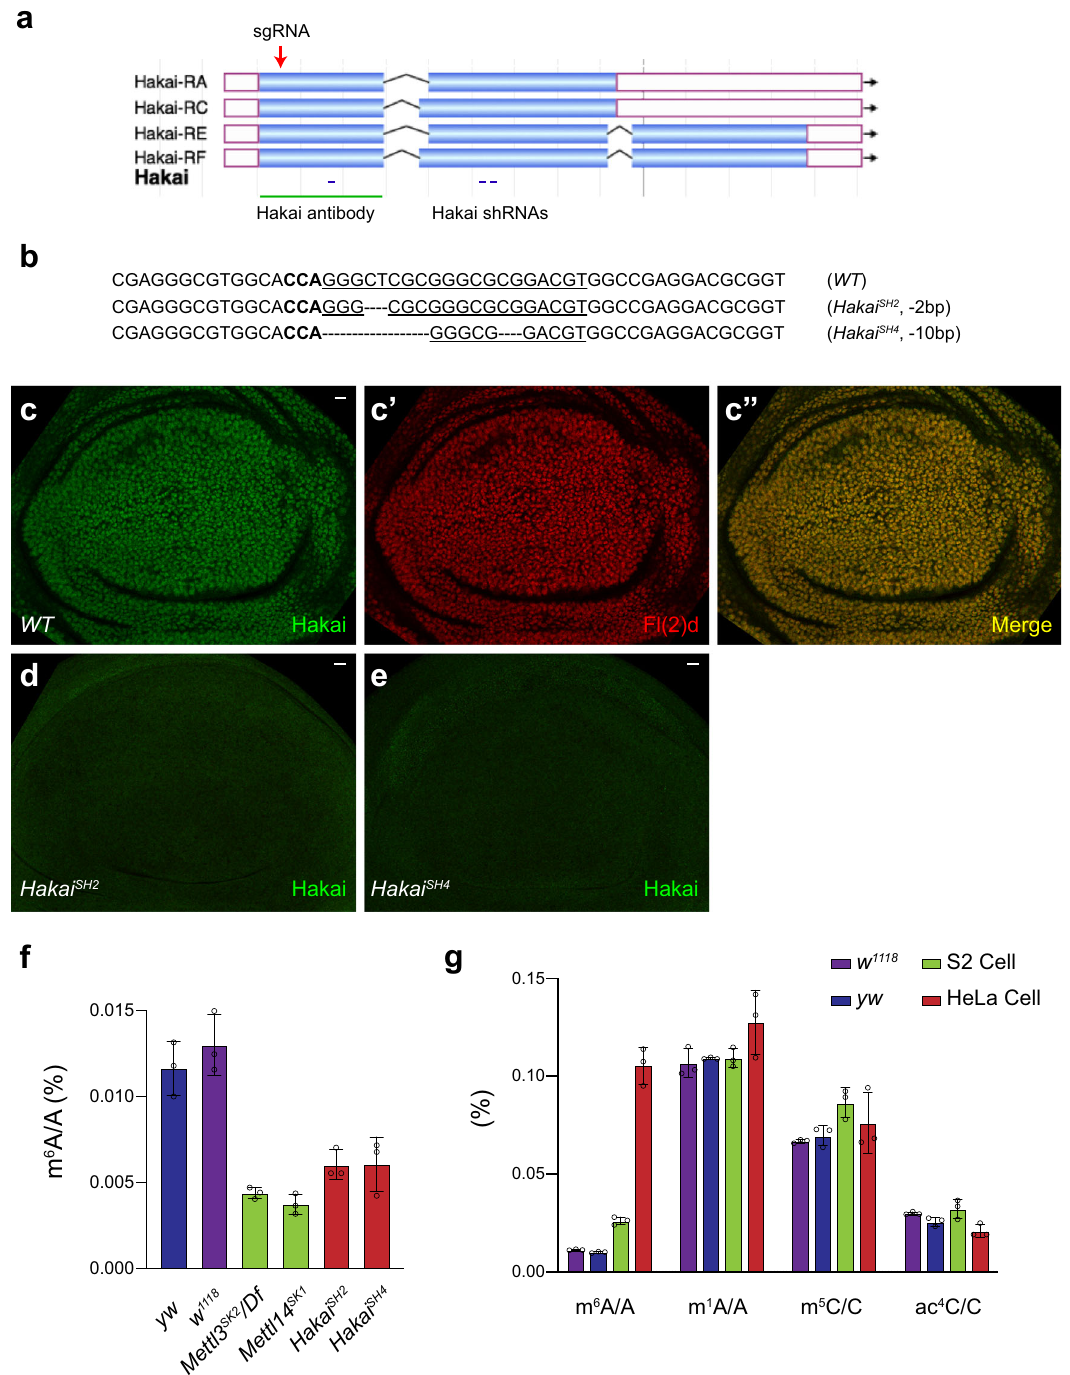
Fig. 2 Hakai is required to maintain proper levels of m 6 A methylation. a Flybase JBrowse view of the Hakai gene locus. Hakai has four transcripts due to alternative splicing that generates two long and two short protein isoforms. The positions of three independent shRNAs, Hakai sgRNA, and the protein region used to generate a Hakai antibody are indicated. b Sequencing results showing frameshift indels in Hakai SH2 and Hakai SH4 fl ies generated by CRISPR/Cas9-mediated mutagenesis. The targeted genomic DNA sequence is underlined and the NGG PAM sequence is in bold type. c – c ” Hakai and Fl(2) d antibody staining in WT wing discs showing a high degree of co-localization. Hakai antibody staining was strongly reduced in Hakai SH2 ( d ) or Hakai SH4 ( e ) homozygous mutant wing discs. The experiments in c – e were repeated at least twice independently with similar results, and each time around 30 wing discs for any genotype were examined. Scale bars: 10 μ m. f Quanti fi cations of m 6 A relative to A in mRNA extracted from male adult fl ies by LC-MS. Compared to yw and w 1118 controls, m 6 A levels dropped to about 30% in Mettl3 or Mettl14 mutants and to <50% in Hakai SH2 or Hakai SH4 mutants. g Quanti fi cations of m 6 A/A, m 1 A/A, m 5 C/C, and ac 4 C/C levels in mRNA extracted from yw and w 1118 male fl ies, Drosophila S2 cells, and human HeLa